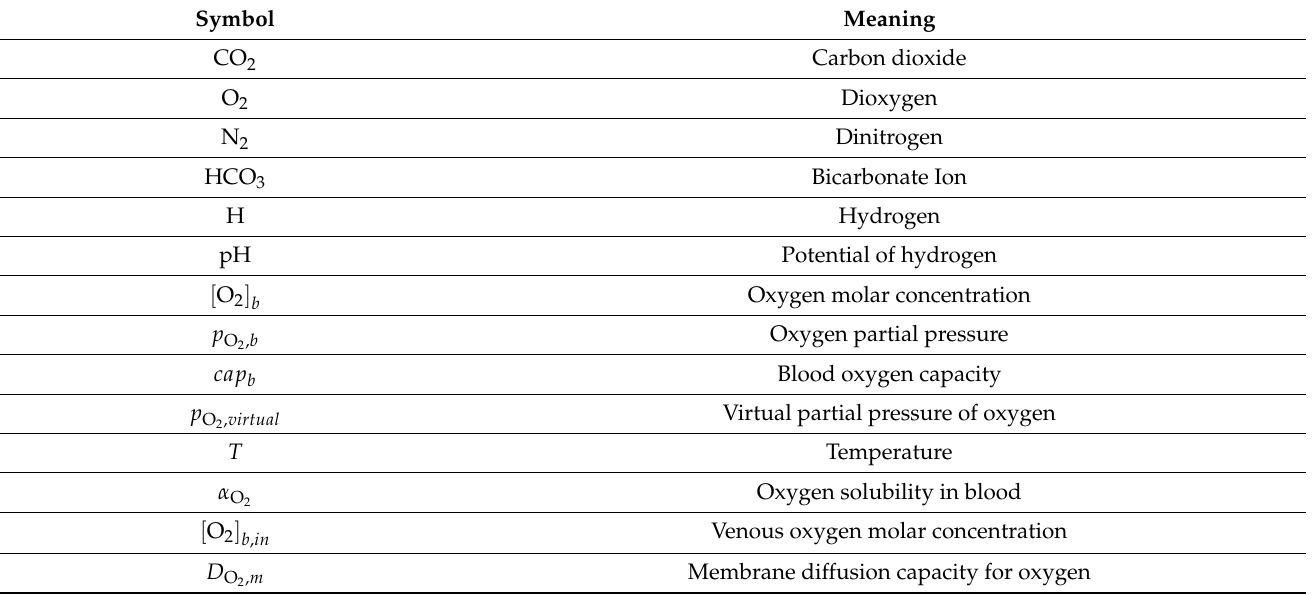
Table A4. List of non-model symbols used in the